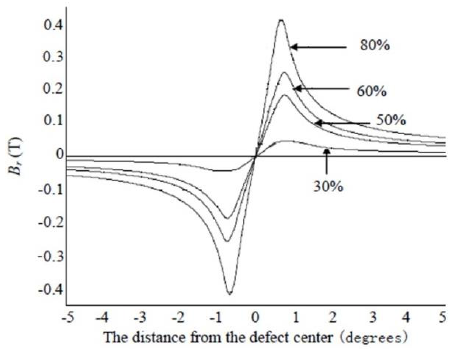
Figure 6. Radial MFL signals with different depth.